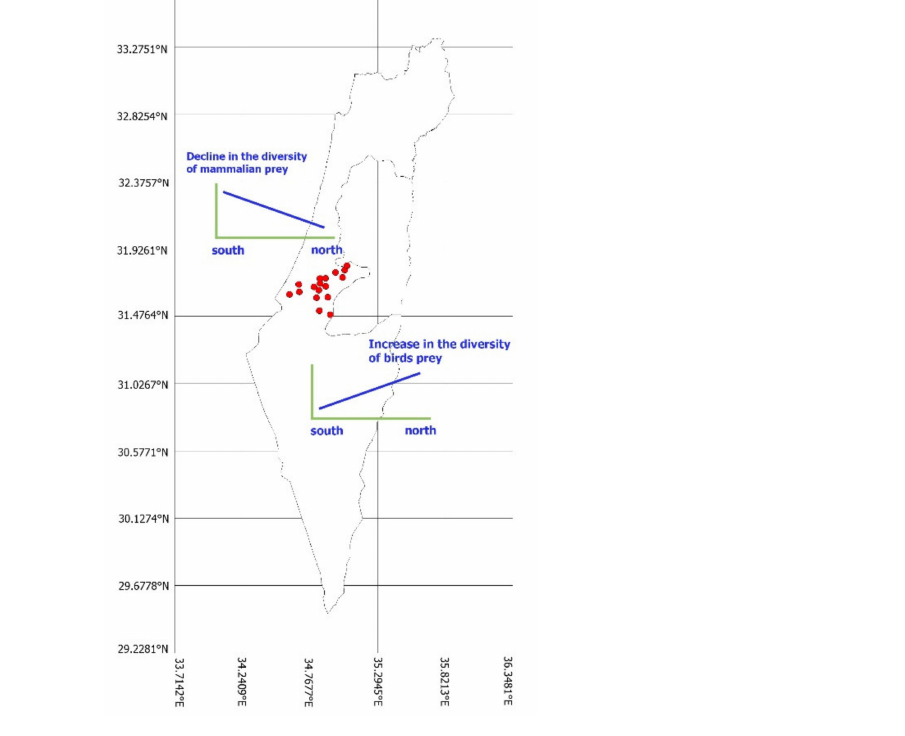
Figure 1. Map of Israel depicting the study area of Judea, central Israel, and the locations of the 14 nest sites (red circles) of Eagle Owls ( Bubo bubo ) at which pellets and prey remains were collected between